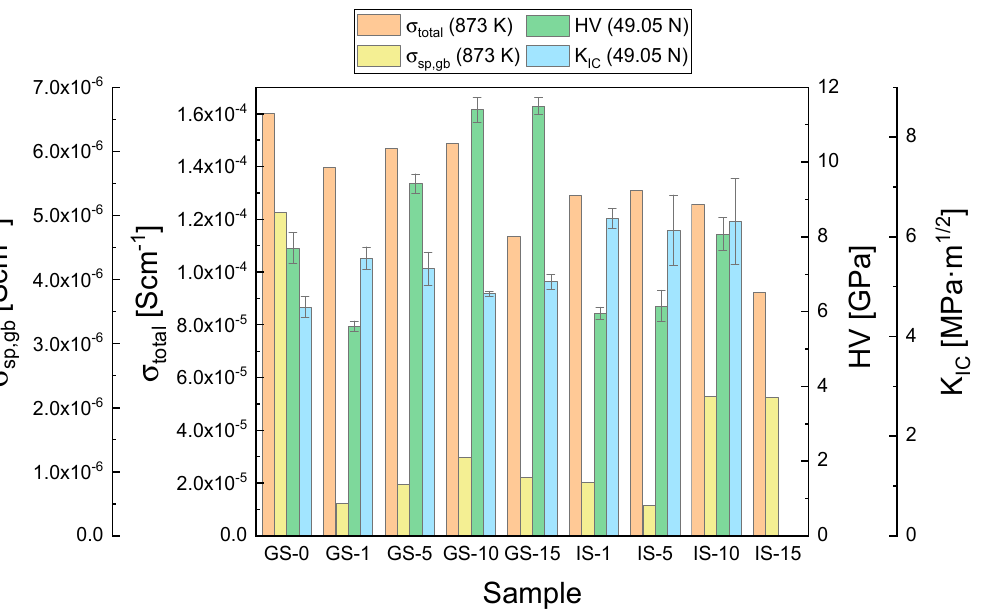
Figure 10. Most significant properties of the studied GS and IS sinters: the total electrical conductivity and specific grain boundary conductivity measured at 873 K, Vickers hardness values (HV), and the critical stress intensity factors (K IC ) at a load of 49.05